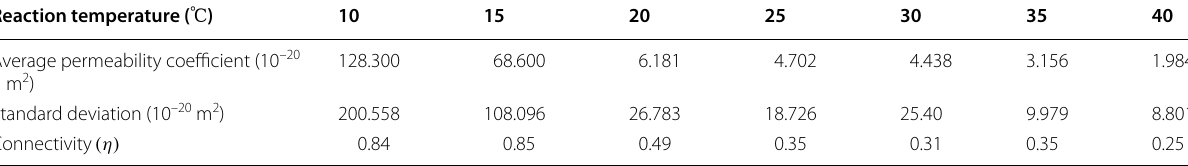
Table 3 Model simulation result at different reaction temperatures with w/c